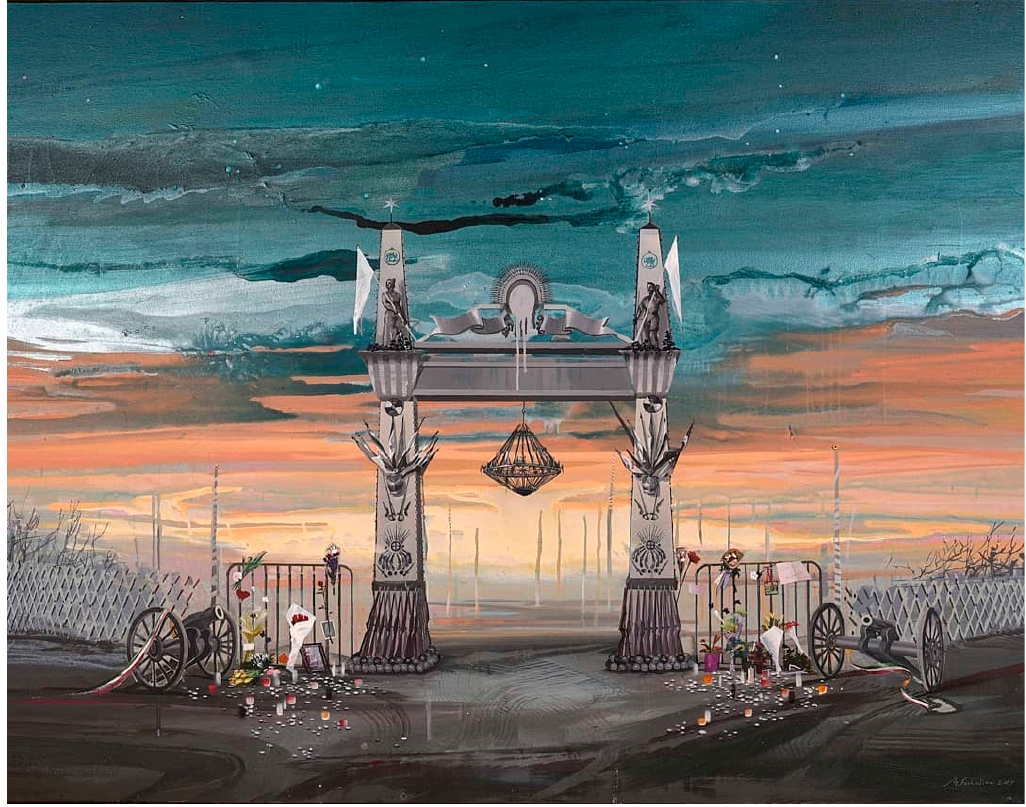
Figure 1. Mehdi Farhadian, After Storm , 2017, acrylic on canvas, 130 × 180 cm.